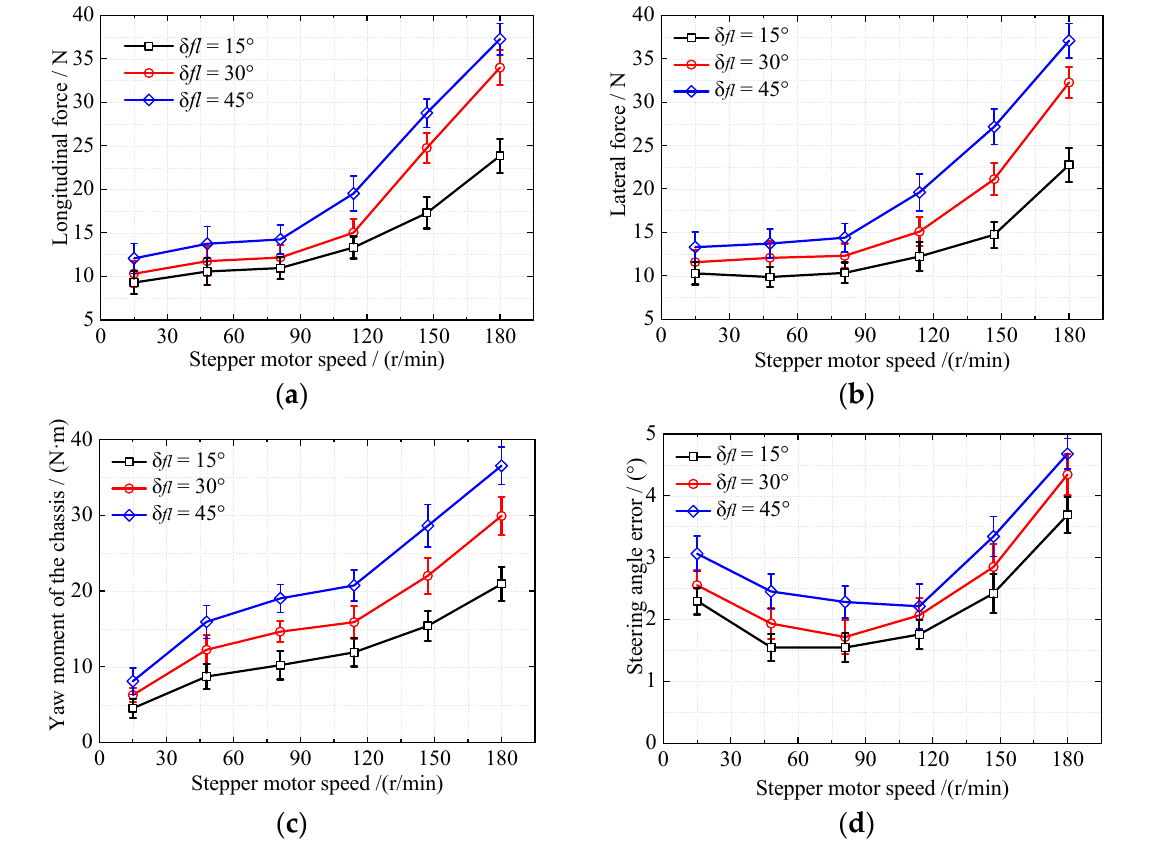
Figure 7. Impact of the stepper motor speed on ( a ) Longitudinal force; ( b ) Lateral force; ( c ) Yaw moment; ( d ) Steering errors.